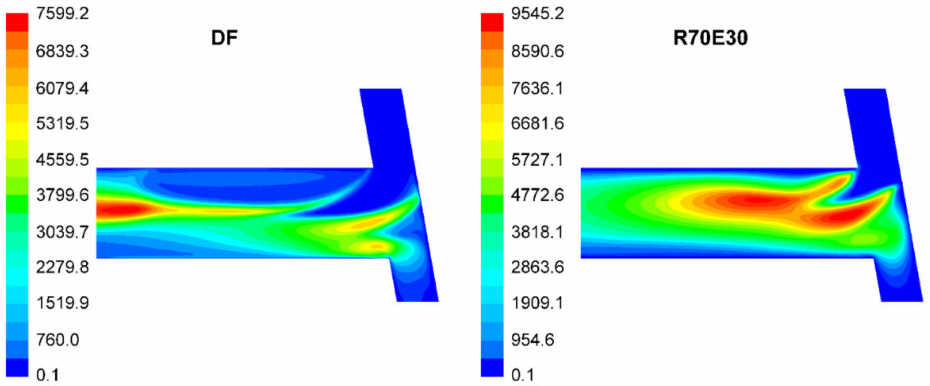
Figure 15. Distribution of TKE (m2/s2) in the longitudinal section of the nozzle hole at backpressure of 8.9